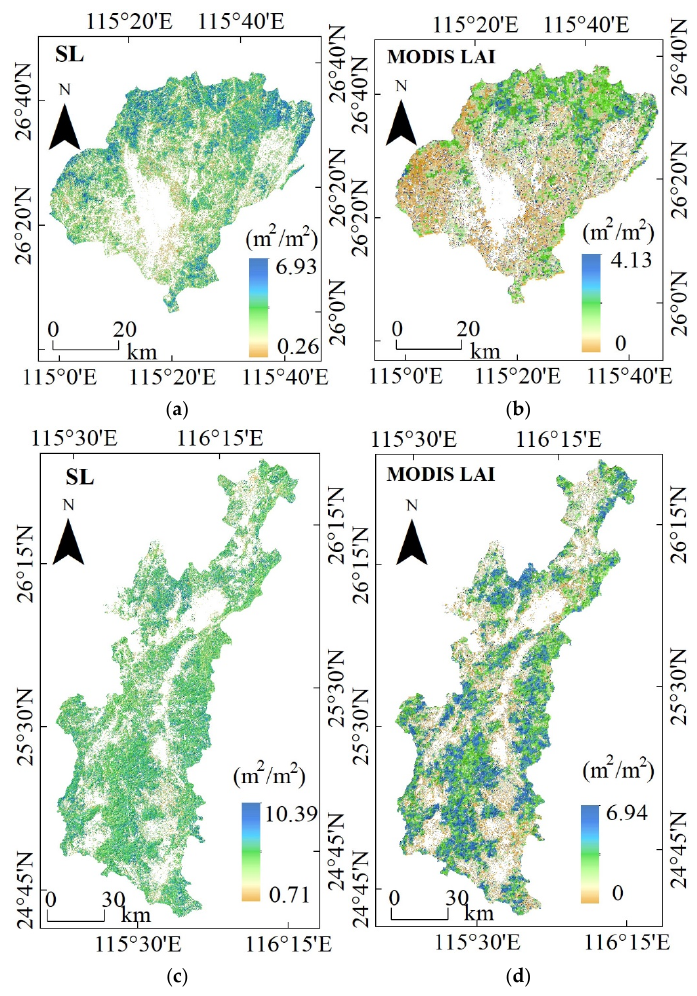
Figure A12. ( a , b ) LAI prediction results in Xingguo and Gandong, respectively. ( c , d ) The MODIS LAI in Xingguo (average of MODIS LAI from 16 November to 23 December 2019) and Gandong (average of MODIS LAI products from 13 July to 19 August 2020).